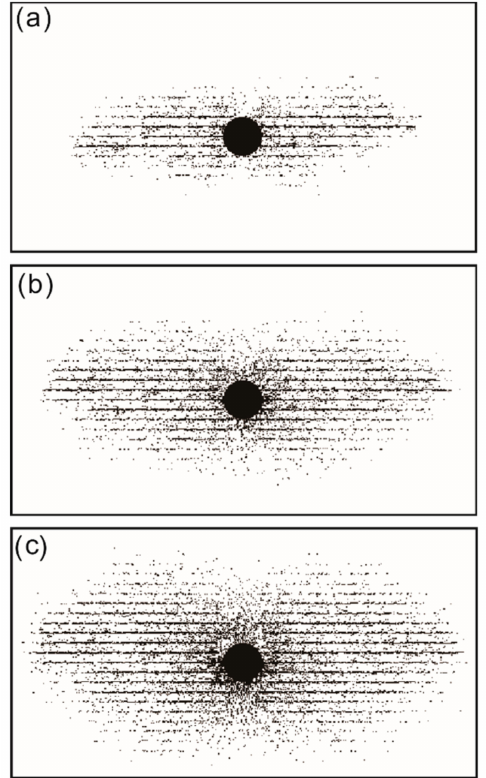
Figure 16. Distribution of the fractures for injection rates of 0.12, 0.15, and 0.18 m 3 · s − 1 · m − 1 for a case with structural planes parallel to σ H and boundary stresses the same as with the base